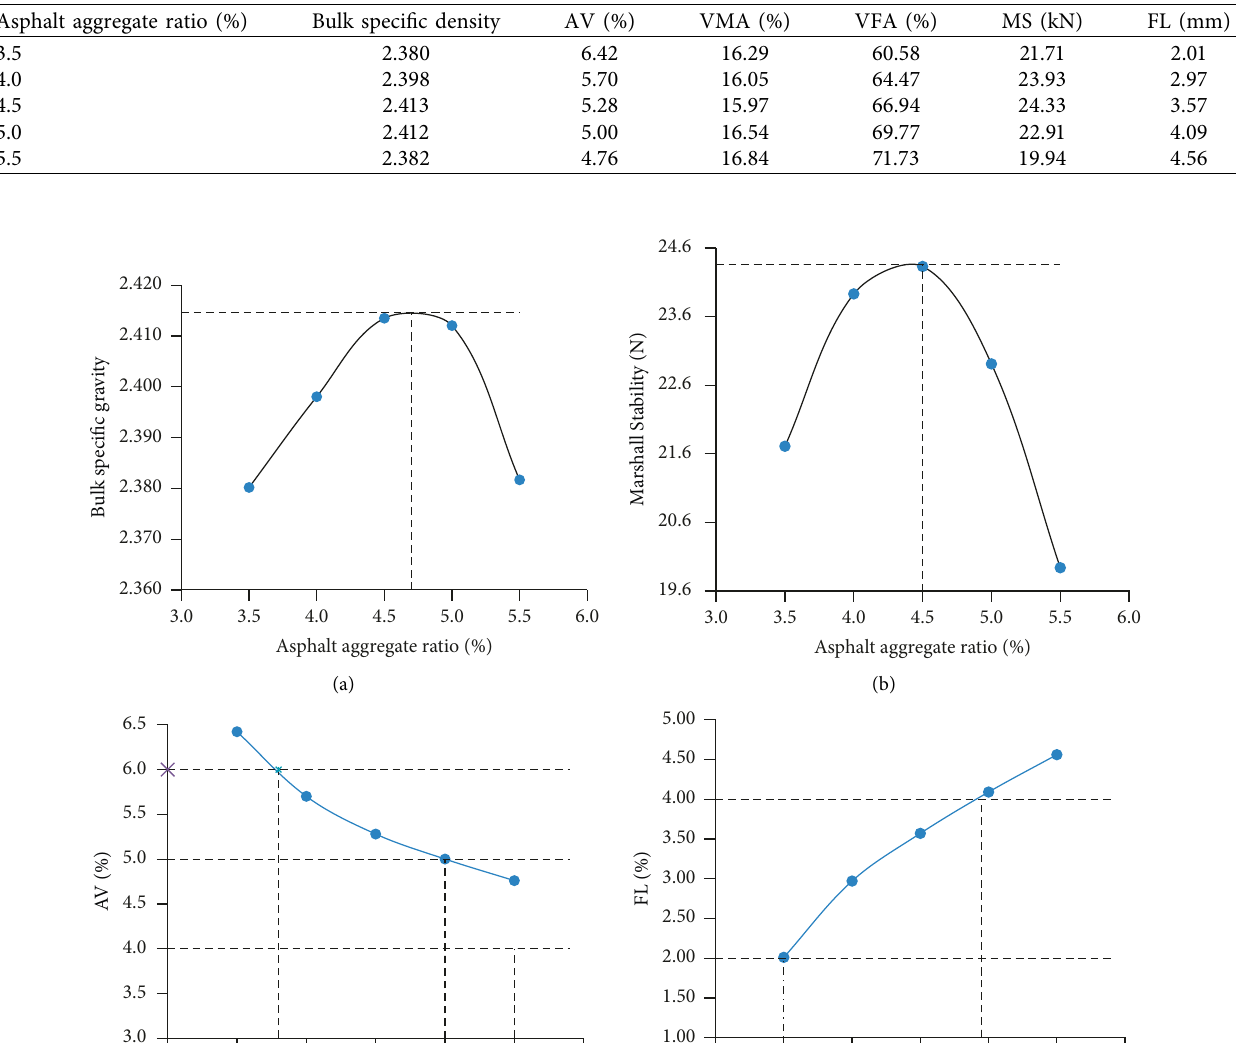
Table 6: Marshall testing results.